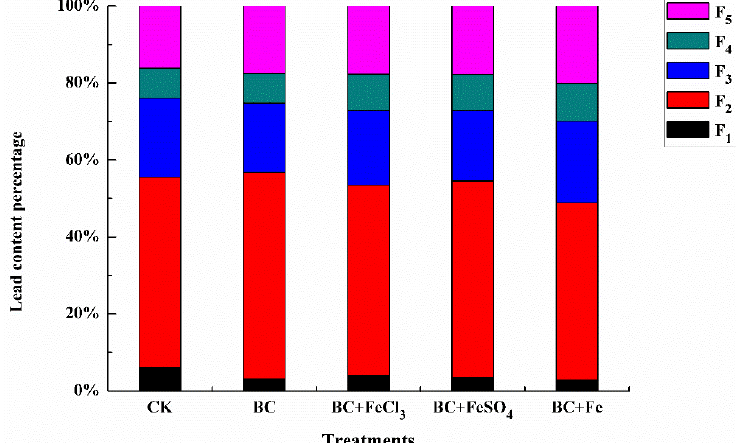
Figure 2. The effect of different treatments on chemical form of Pb in soil.